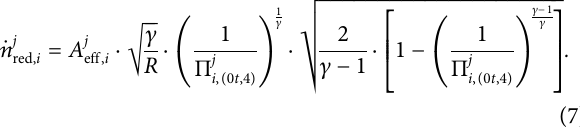
Frontiers in Mechanical Engineering |